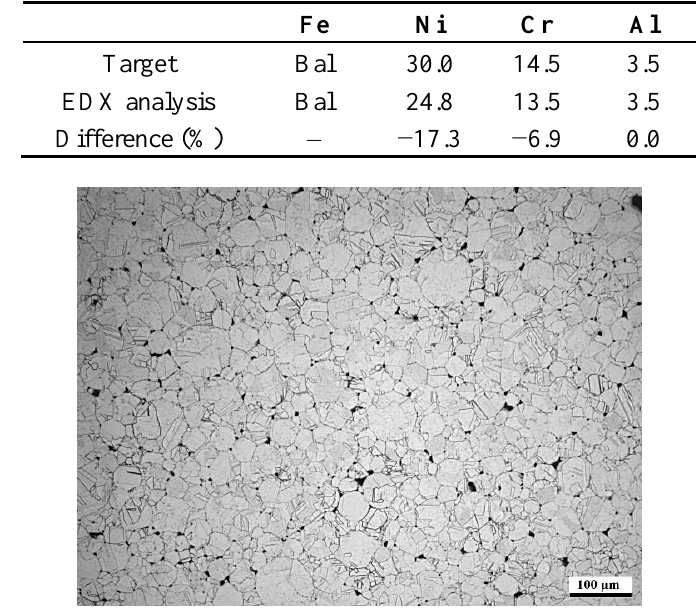
Figure 5. SEM images of gas atomized FeNiCrAl powder sieved 45–125 μm, magnifications with micron bars. ( a ) 100 μm; ( b ) 5 μm. Table 3. EDX analysis of the FeNiCrAl powder in wt % and calculated difference in %.